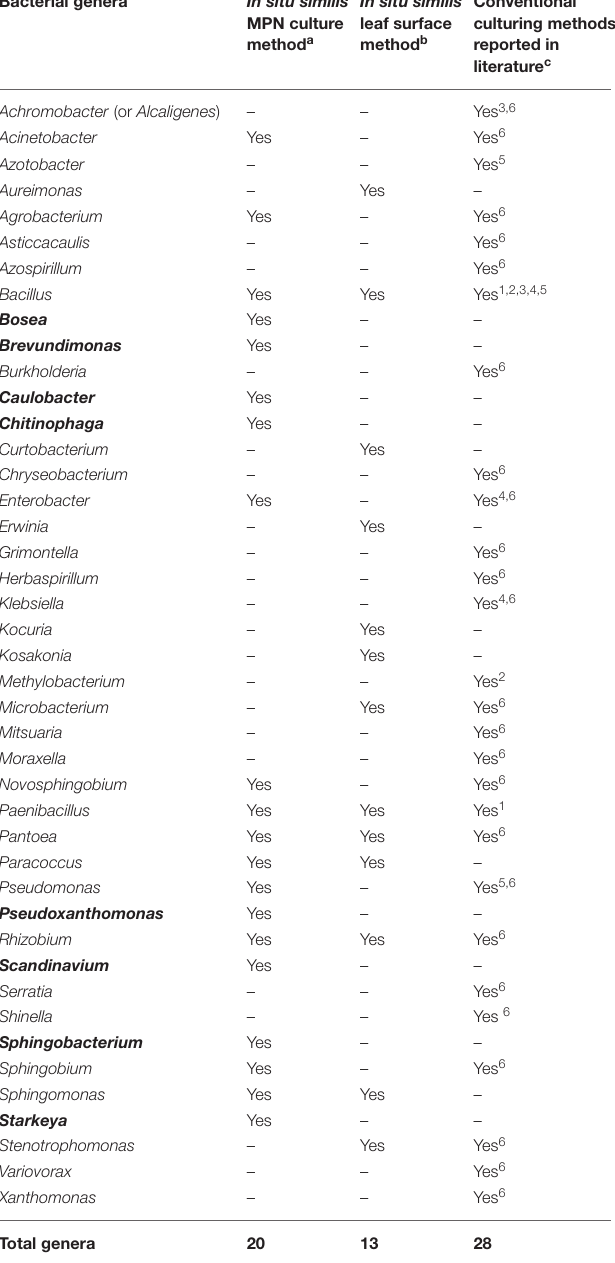
TABLE 4 | Genera of cultivable endophytic bacteria of sunflower isolated by in situ similis culturomic strategies compared to other conventional culturing methods reported in